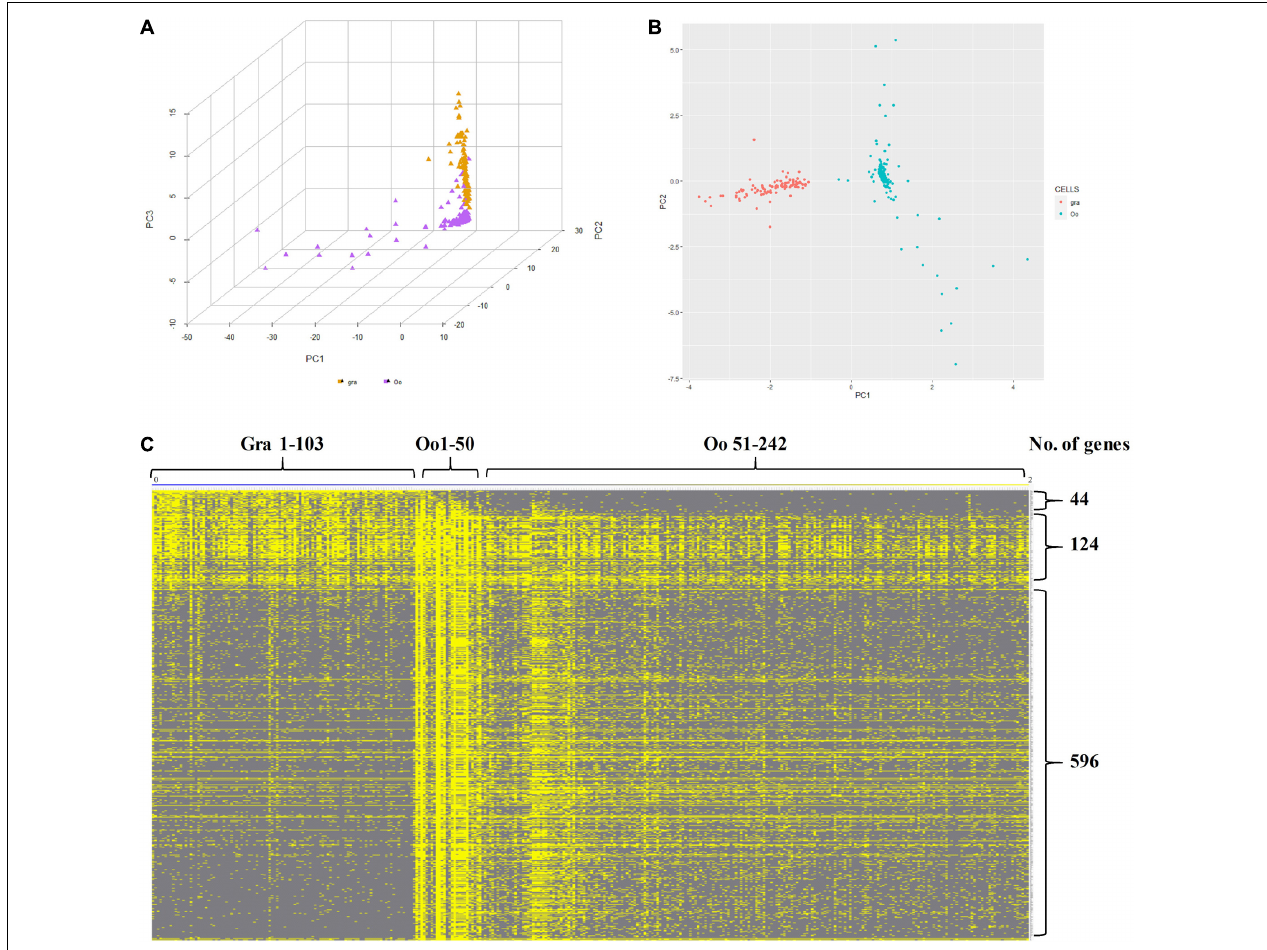
FIGURE 6 | Characteristics of zar1 transcripts enriched cells ( zar1 + ) and dnajb1 transcripts enriched cells ( dnajb1 + ). (A) Principal component analysis (PCA) of the highly expressed genes in zar1 transcripts enriched germ cells ( zar1 + ) and dnajb1 transcripts enriched granulosa cells. Oo and Gra represent zar1 transcripts enriched germ cells ( zar1 + ) and dnajb1 transcripts enriched granulosa cells, respectively. (B) Significantly KEGG signaling pathways of the highly expressed genes in zar1 transcripts enriched germ cells ( zar1 + ) and dnajb1 transcripts enriched granulosa cells. (C) Heatmap of the highly expressed genes in zar1 transcripts enriched germ cells ( zar1 + ) and dnajb1 transcripts enriched granulosa cells. Oo and Gra represent zar1 transcripts enriched germ cells ( zar1 + ) and dnajb1 transcripts enriched granulosa cells,